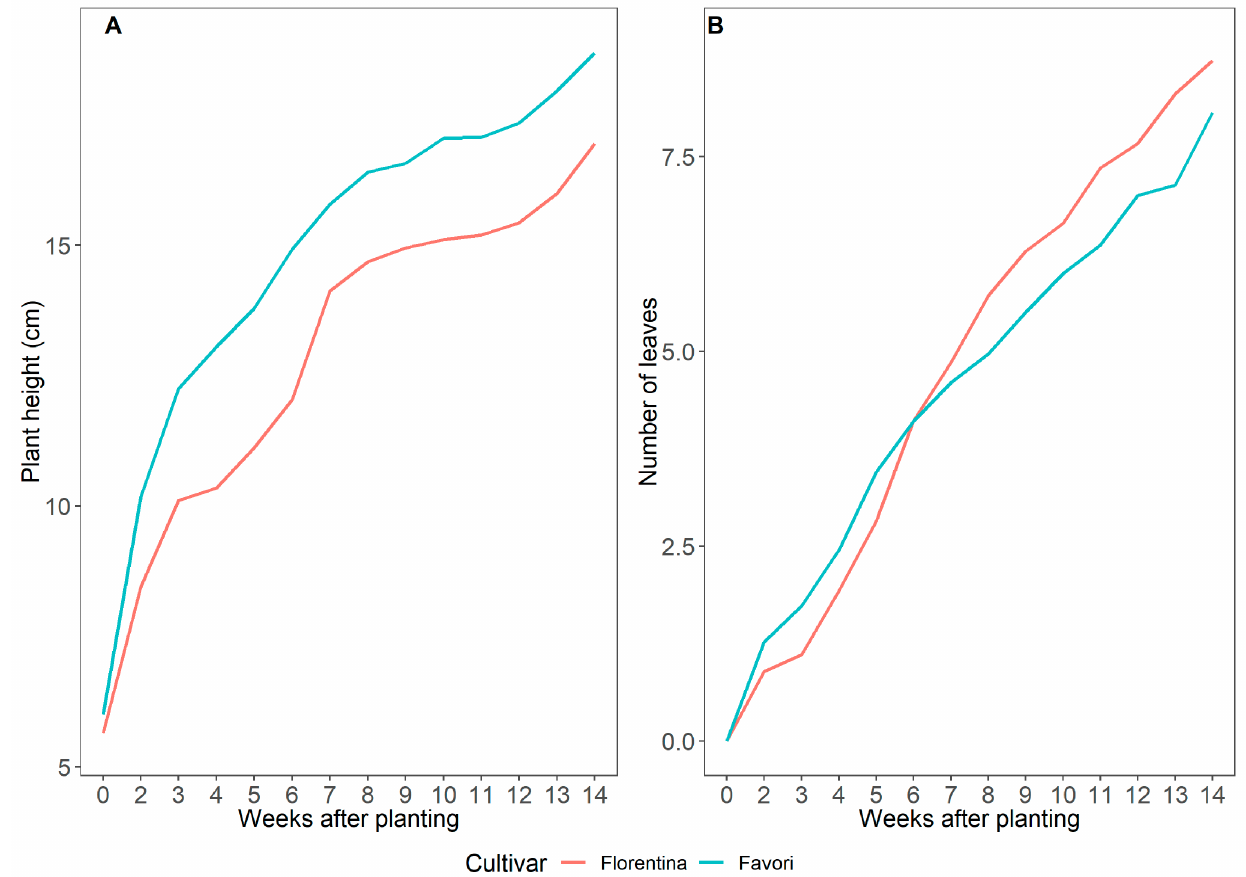
Figure 8. Average plant height ( A ) and total number of leaves ( B ) for ‘Florentina’ and ‘Favori’ strawberry plants grown at ambient long day at 20 ◦ C for 14 weeks (N =